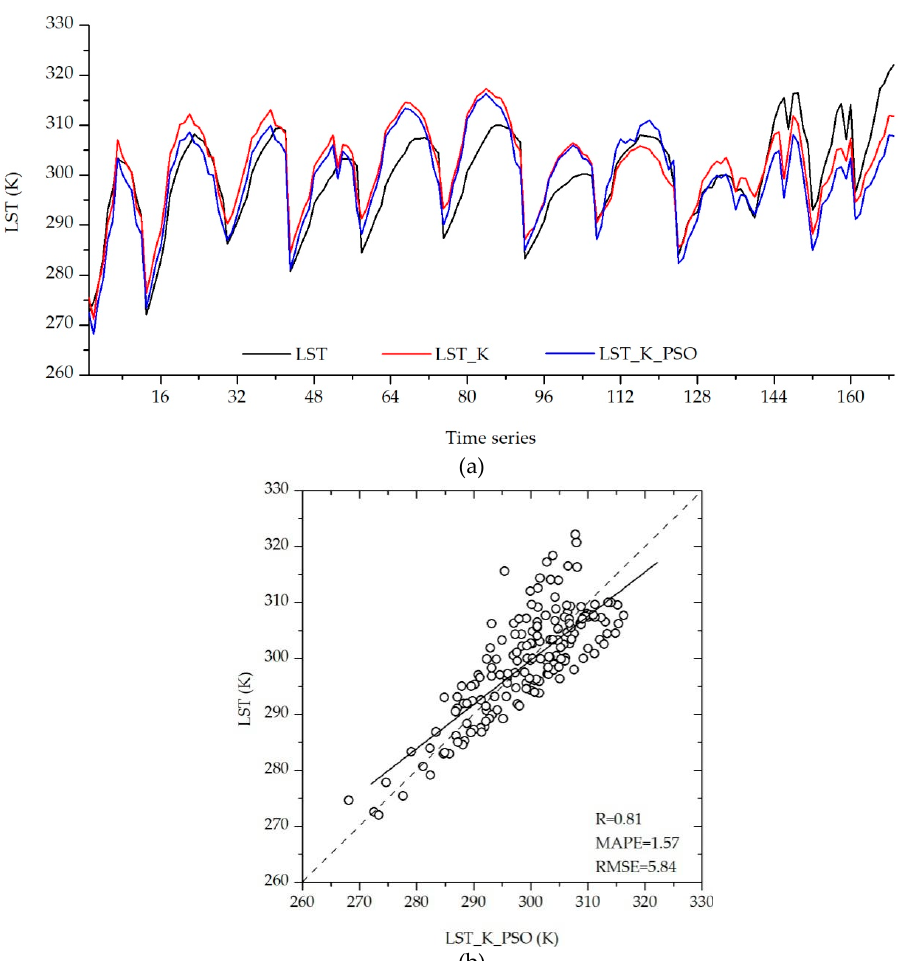
Figure 8 . The comparison of LST retrieved by the optimized Kerr algorithm and measured values; ( a ) is the time series , ( b ) is the scatters.